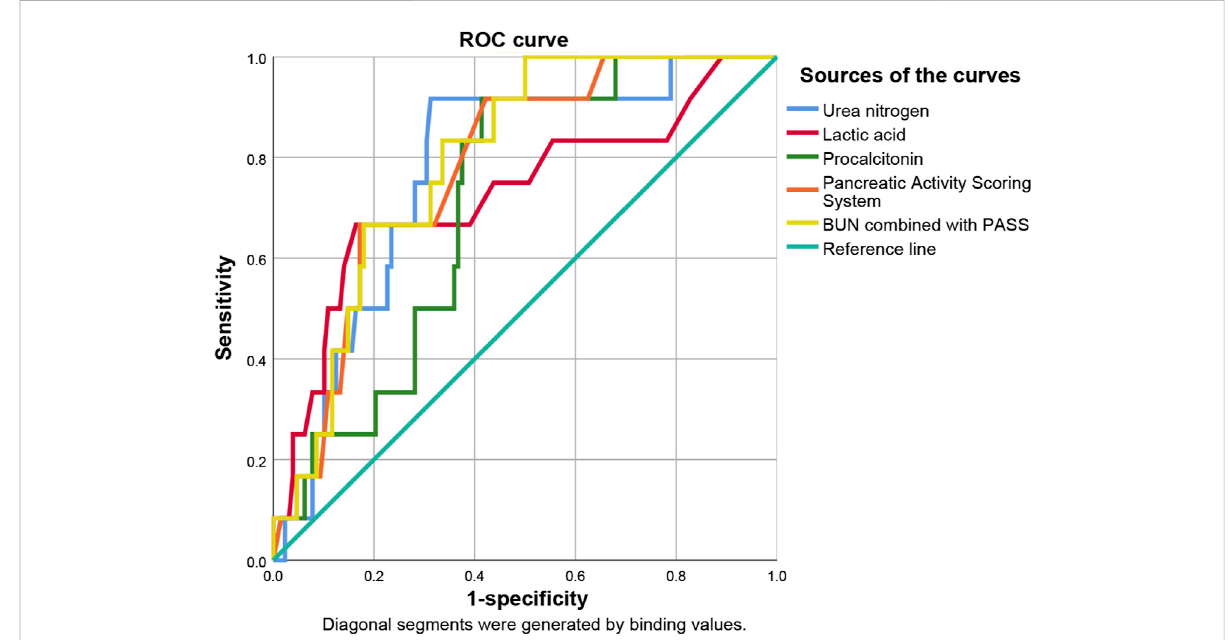
FIGURE 6 Predictive ef fi cacy for in-hospital mortality of clinical parameters of AP. AP: acute pancreatitis.